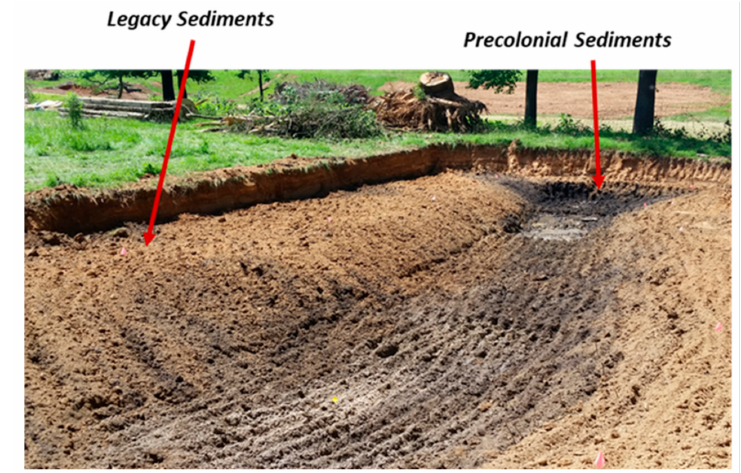
Figure 10. Channel construction along Stick Elliott Road. The banks of the newly constructed channel will consist of easily eroded legacy sediments, whereas the channel bed will rest on more resistant, and finer-grained, precolonial deposits.